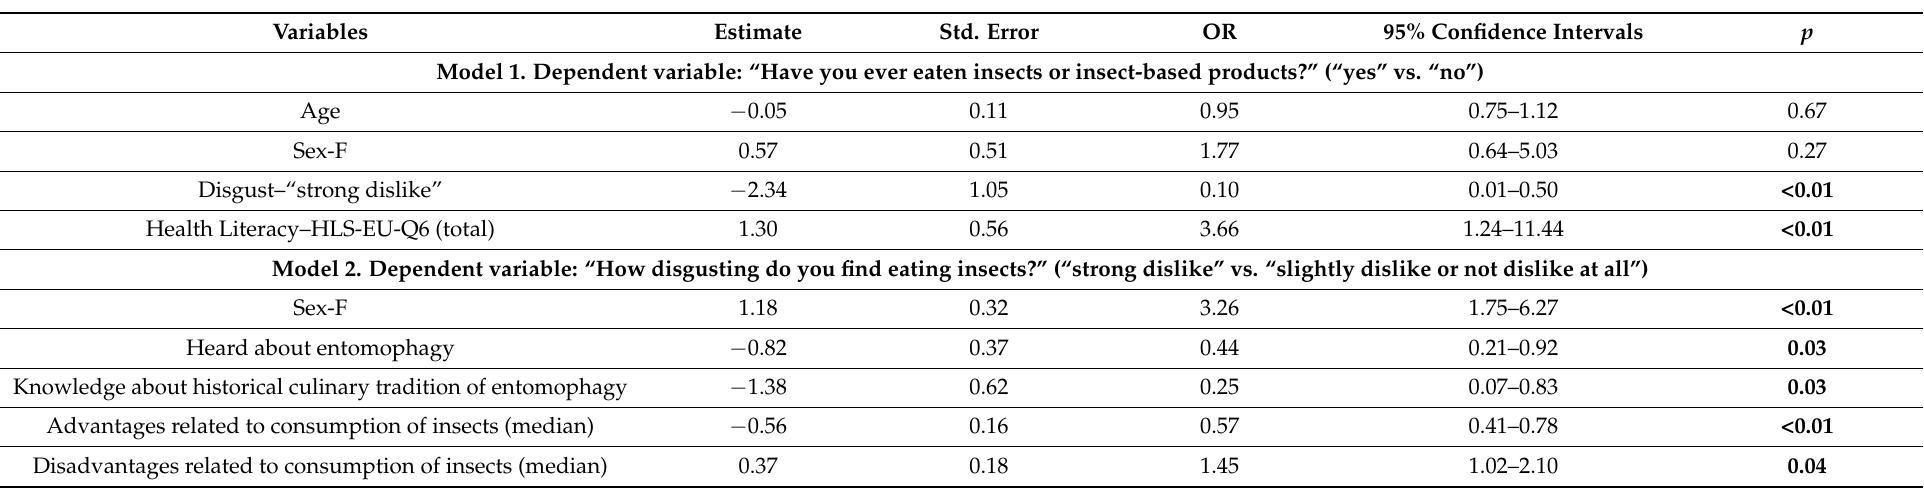
Table 2. Multivariate logistic regression models. Dependent variables: “Have you ever eaten insects or insect-based products?” answer (model 1) and “Zero to four, how disgusting do you find eating insects?” answer (model 2). With the latter, grouped answers (0–3 vs. 4) have been chosen to fit the model. The bold suggest that between those variables there is a significant